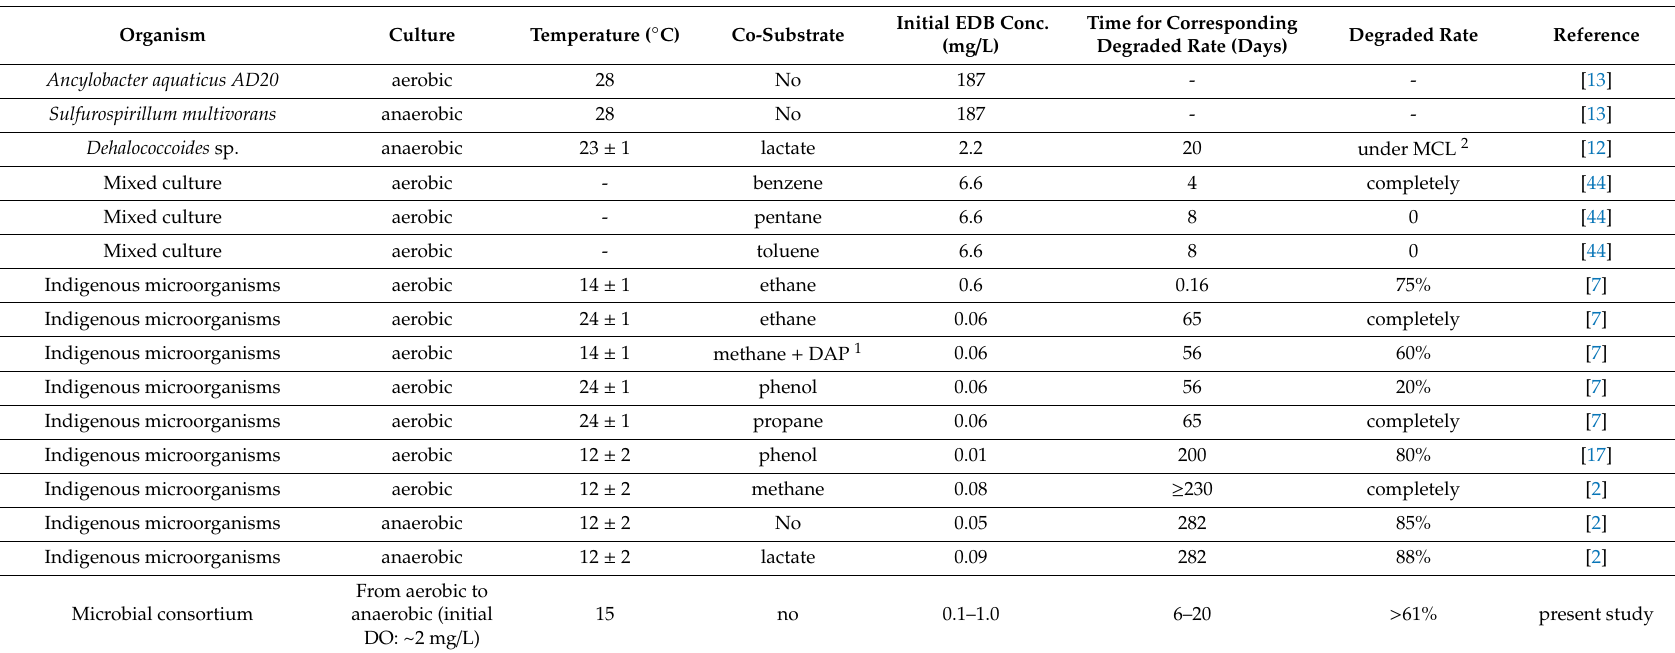
Microbial consortium